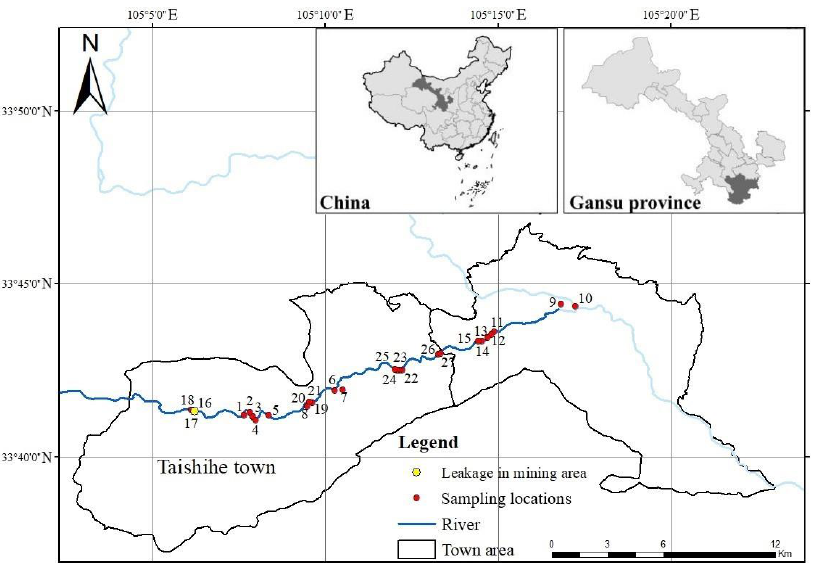
Figure 1. Map of the study area and sampling locations. The numbers on the figure indicate the point numbers of the sampling locations. There are 27 sampling points.